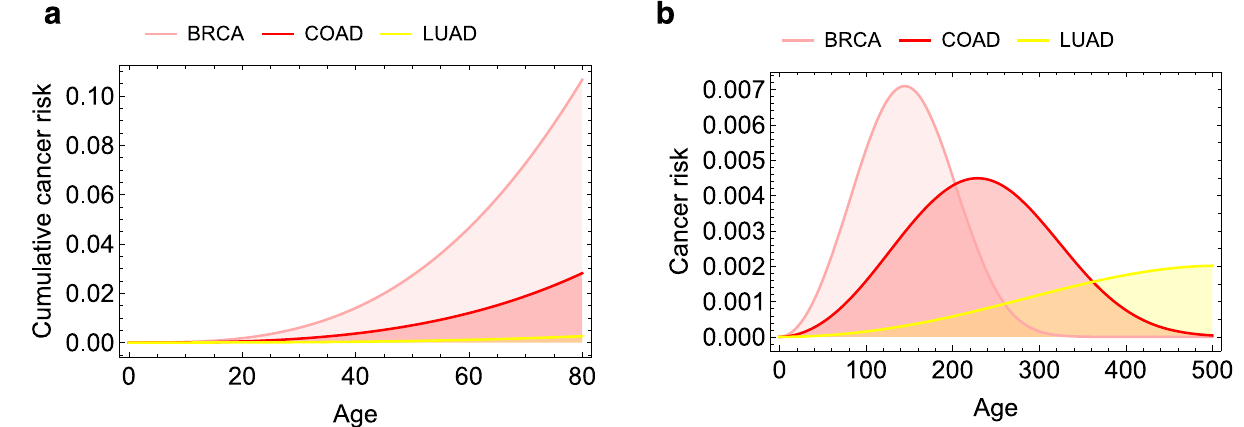
Fig. 3 | Cancerriskasafunction of age for threetypes ofcancer(breast, colon, and lung), as given by the Weibull distribution (4). a Cumulative distribution function (corresponding to the cumulative cancer risk), b probability density